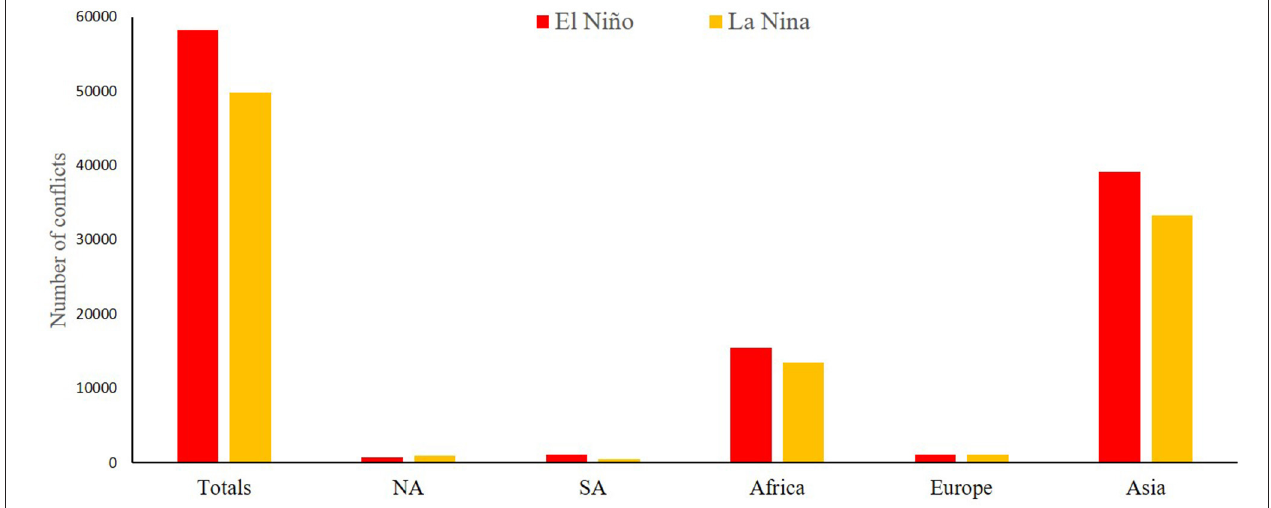
FIGURE 1 | Conflicts at the global and continental scale during El Niño and La Niña years during 1989–2014.